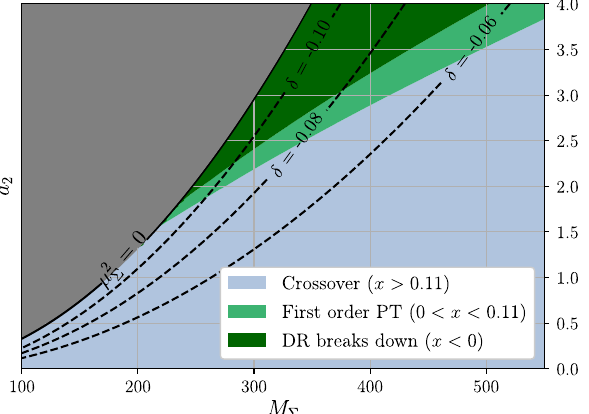
Fig. 11.5 EW phase diagram for the real triplet extension of the SM scalar sector. Horizontal axis gives the triplet mass and vertical axis indicates the triplet-Higgs coupling. Light blue and green regions correspond to cross-over and first order transitions. Dark green (“DR breaks down”) and grey regions indicate parameter choices for which the present non-perturbative computations are not applicable. Dashed lines indicate relative shift in the Higgs diphoton decay rate. From Ref. [331]